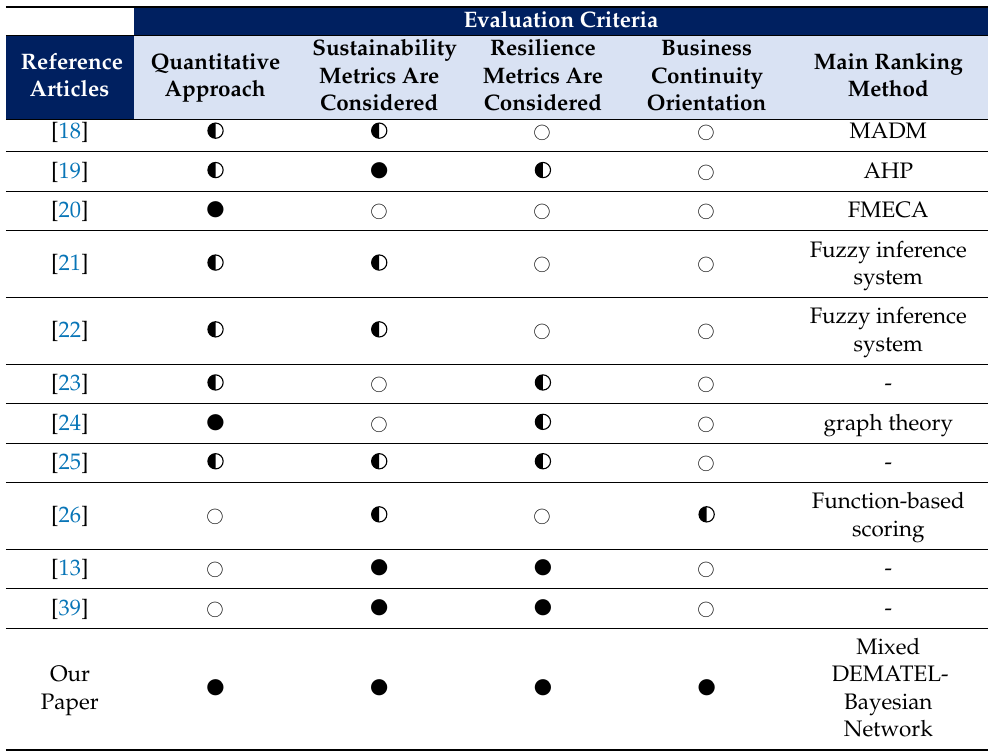
Table 1. A summary of the reviewed articles and their